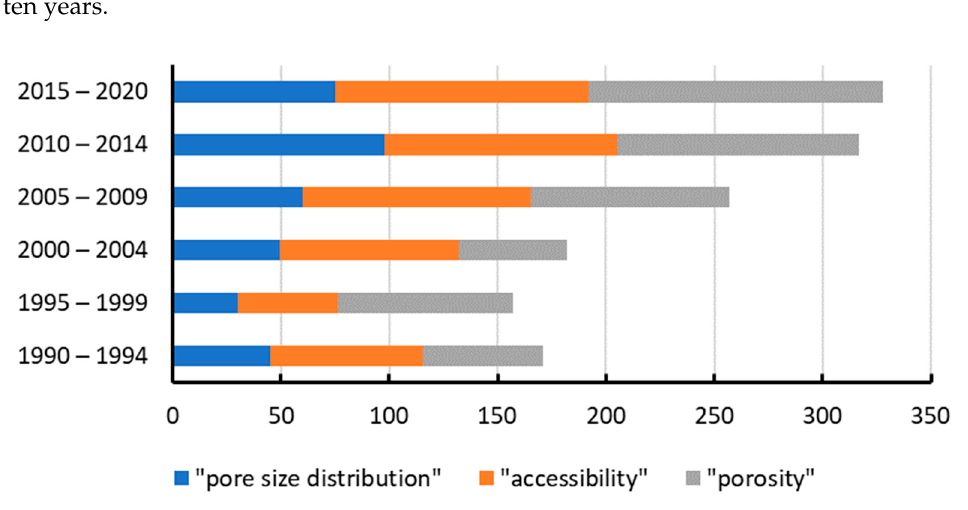
Figure 3. Articles retrieved with the Refining Terms distributed in 5-year clusters . Selected publications were found in 64 journal articles and book sections in a non- uniform distribution: only ten journals concentrated 174 articles (72.5% of the total amount), as depicted in Figure 4. Figure 4. Number of articles published in top ten journals 1990–2020. A similar search was made using the Scopus database, resulting in Table 2. Table 2. Scopus results from 1990 to 2020. Keywords